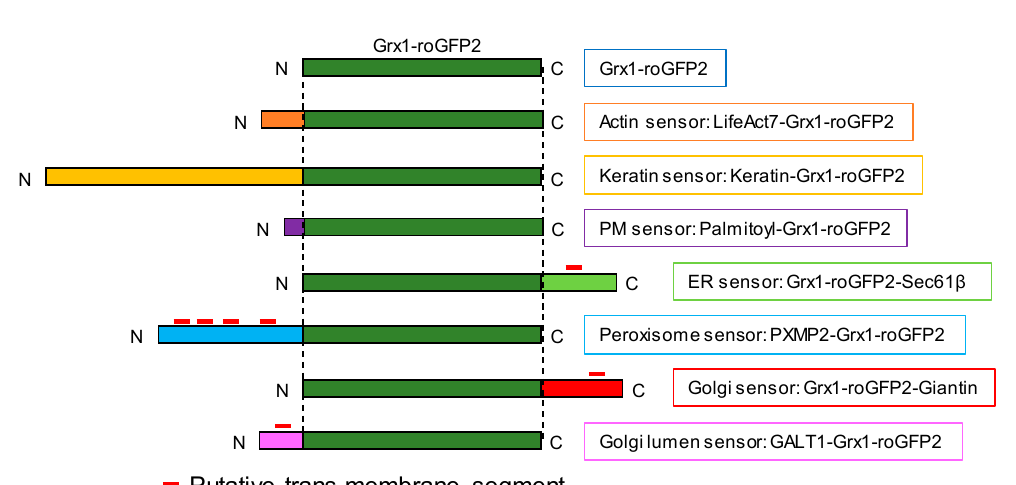
Figure 1. Construction of glutathione oxidation sensor (Grx1-roGFP2) targeted to the cytoplasmic sides of various organelle membranes and cytoskeletons. Grx1-roGFP2 sequence (green box) were fused with exogenous sequences in specific membrane topologies so that the sensor faced to the cytosolic side. GALT1-Grx1-roGFP2 was designed to orient the sensor domain to the lumen. Transmembrane segments were predicted by SOSUI [32] and are indicated by red lines.